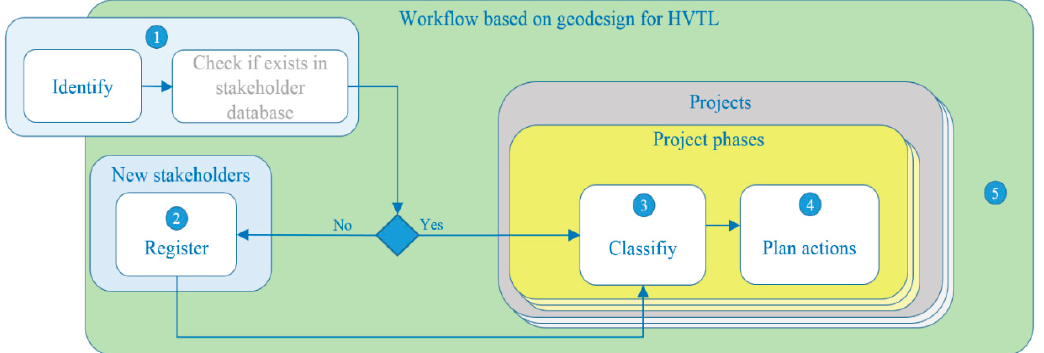
Figure 2. Proposed workflow in systematic stakeholder management.